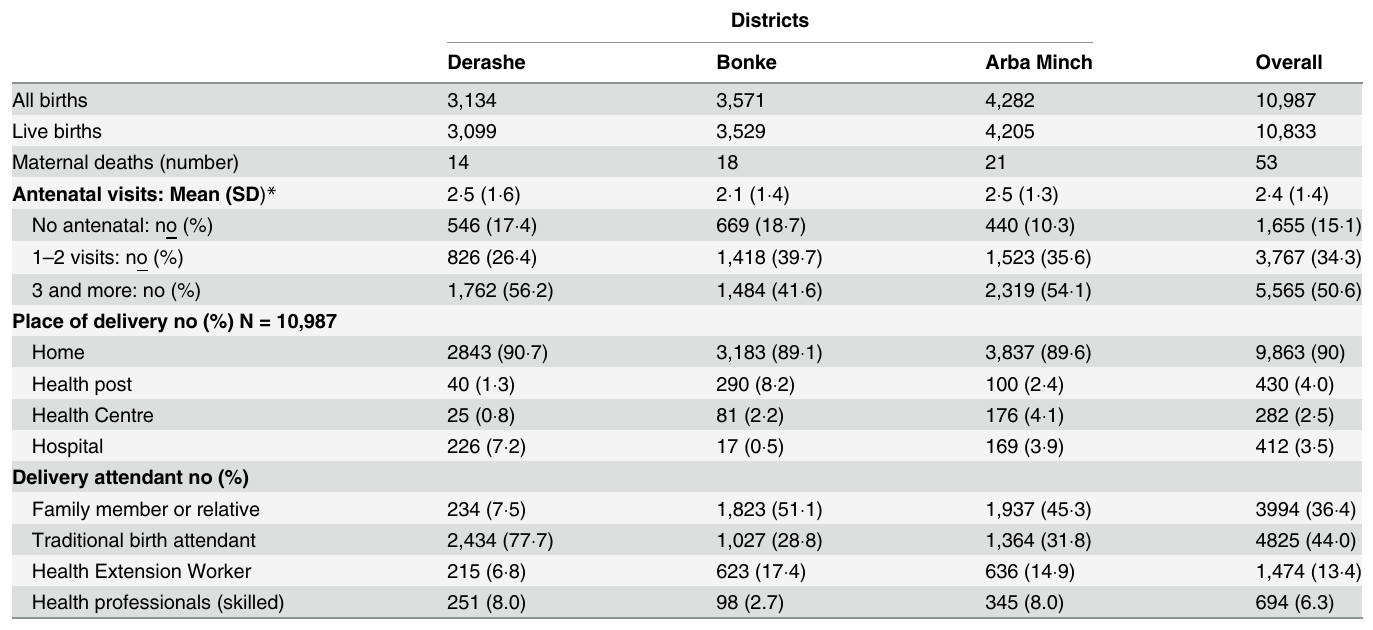
Table 2. District distribution of births, birth outcomes, and services during pregnancy and delivery in south Ethiopia in